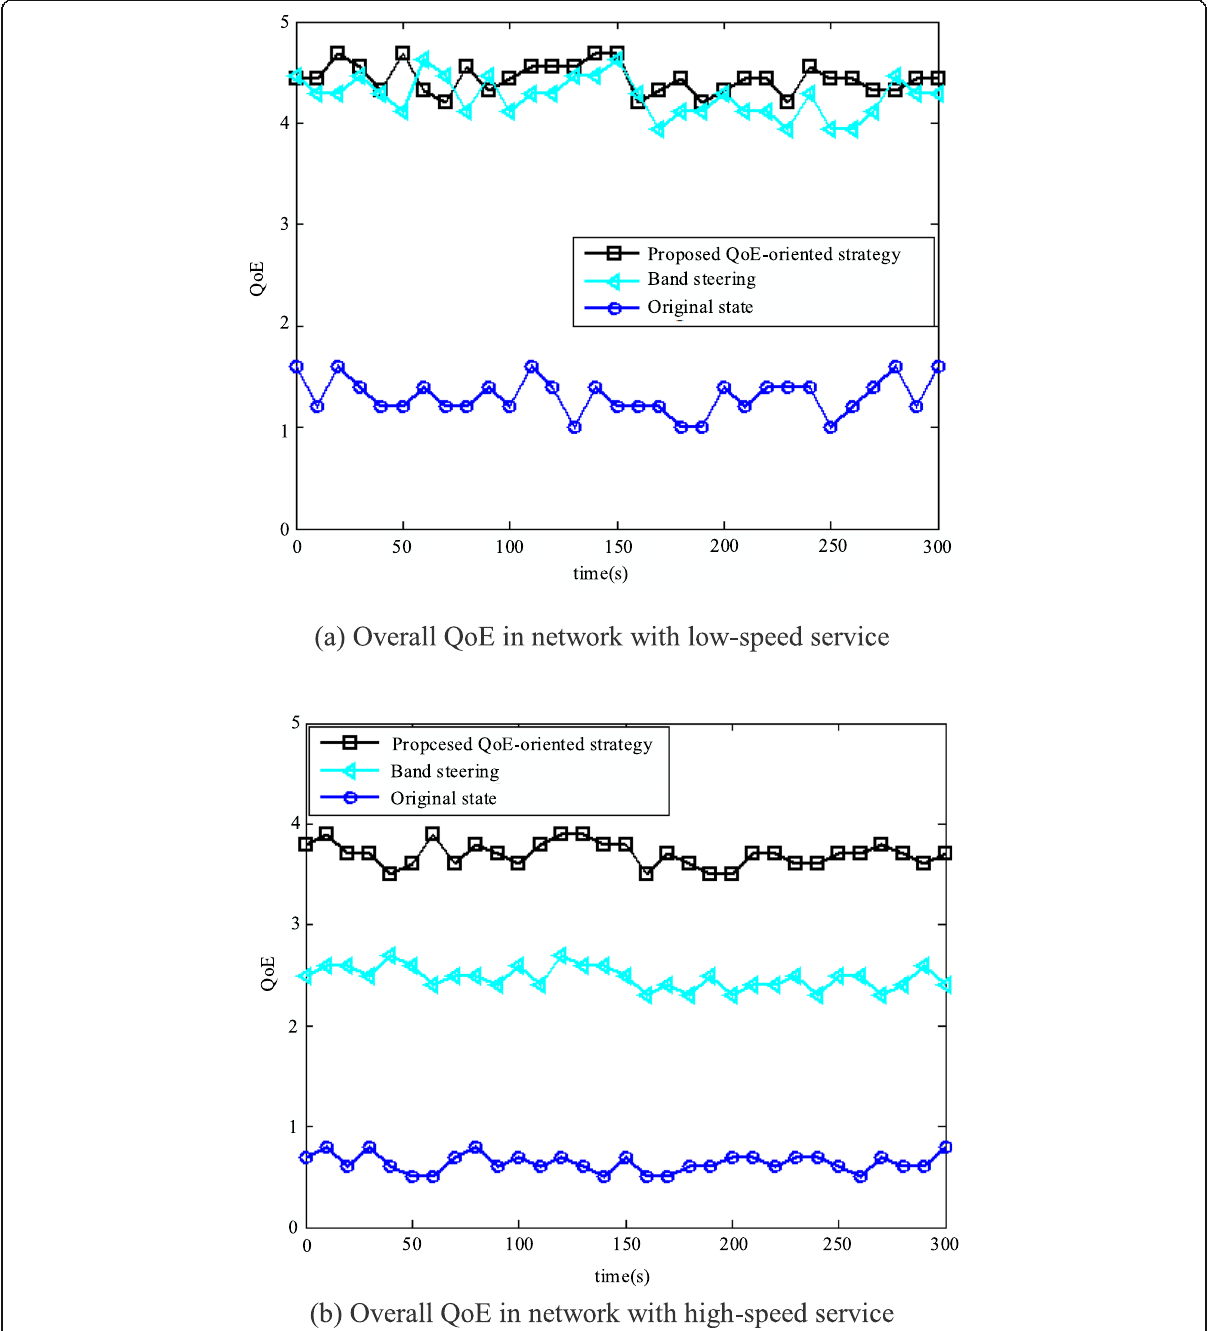
Fig. 7 Overall QoE of users in the network. a Overall QoE in network with low-speed service. b Overall QoE in network with high-speed